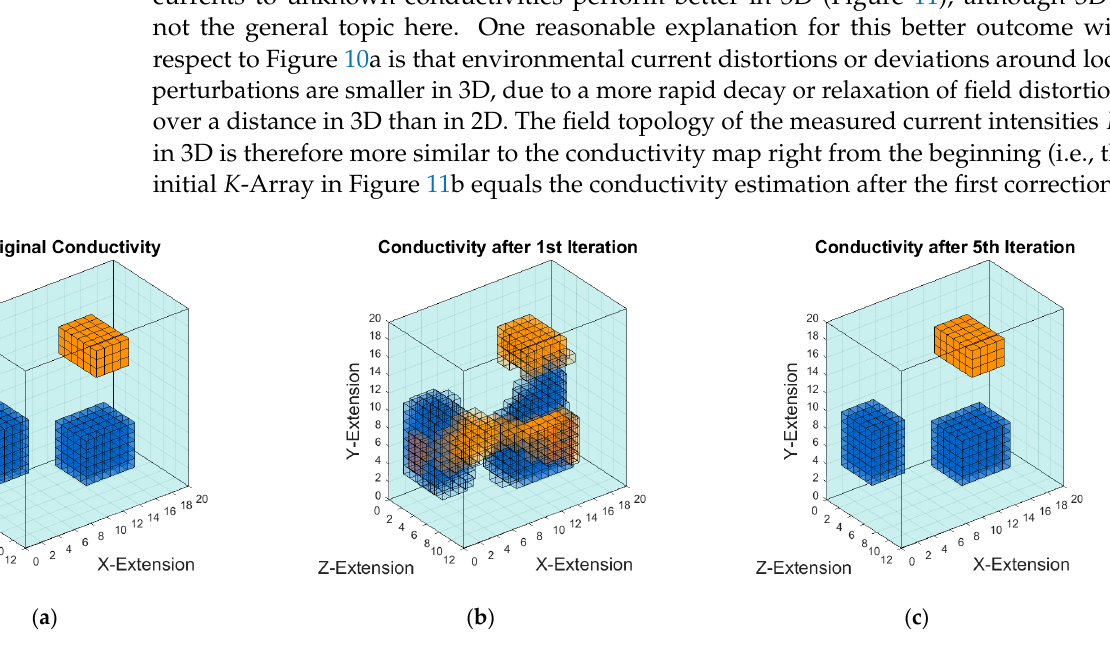
Figure 11. Conductivity reconstruction of a weakly conductive and inhomogeneous 3D body from ideally known eddy currents. The orange color indicates the conductivity 1 S/m. Blue objects indicate 0.25 S/m conductivity, background 0.5 S/m: ( a ) Original object with disturbances; ( b ) 3D reconstruction after the 1st iteration; ( c ) 3D reconstruction after the 5th iteration.